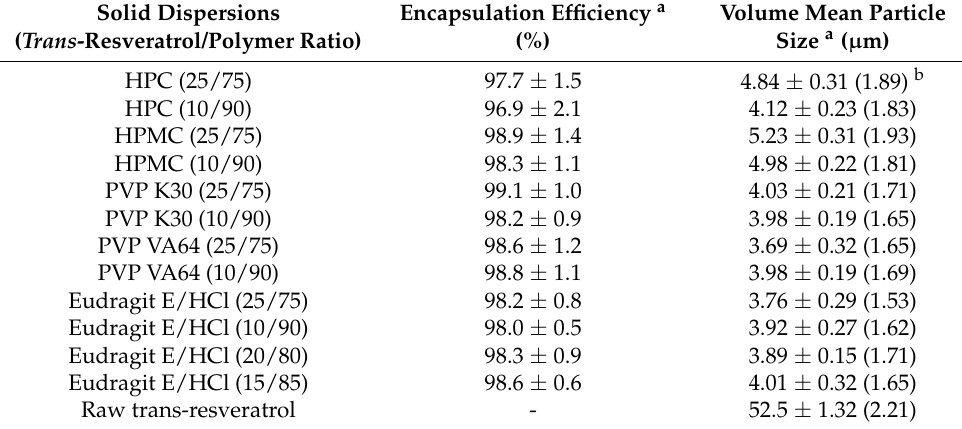
Table 1. Encapsulation efficiency and particle size of raw trans -resveratrol and solid dispersion powders produced using the spray drying